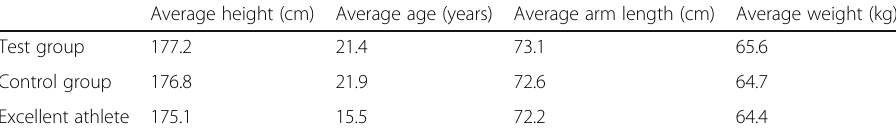
Table 1 Comparison of the average physical condition of experimental group students, control group students, and high-level